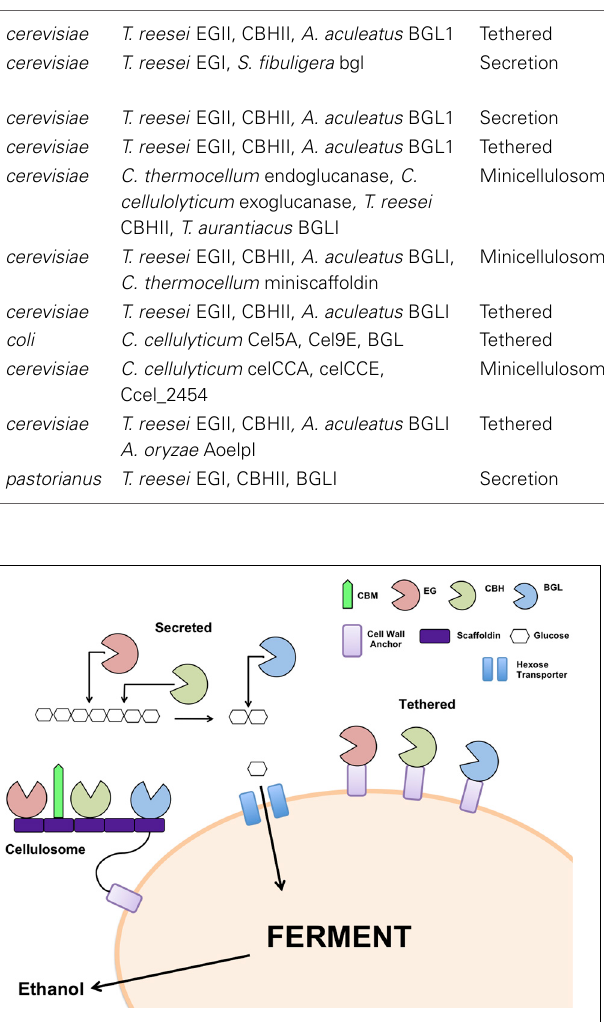
FIGURE 1 | Models for cellulase expression in yeast; heterologous cellulases can be secreted into the medium, tethered individually to the cell wall or assembled into a cellulosome. EG: Endoglucanase, CBH: Cellobiohydrolase, BGL: β -glucosidase, CBM: Cellulose binding module.